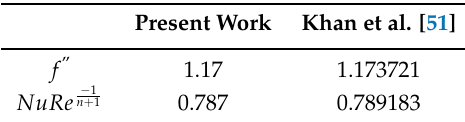
Table 3. Comparison of the f between the present results and those obtained previously [51] for